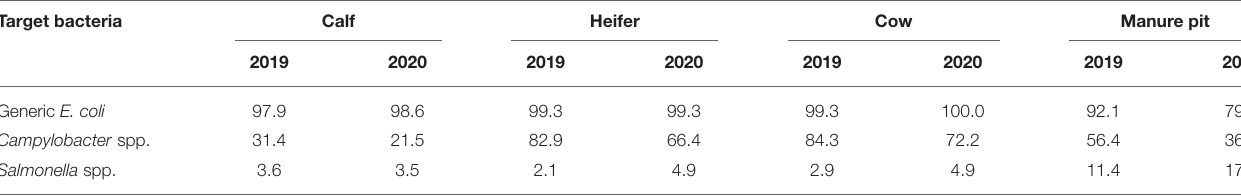
TABLE 2 | Proportion (%) of fecal samples positive for target bacteria processed in 2019 a and 2020 b . Target bacteria